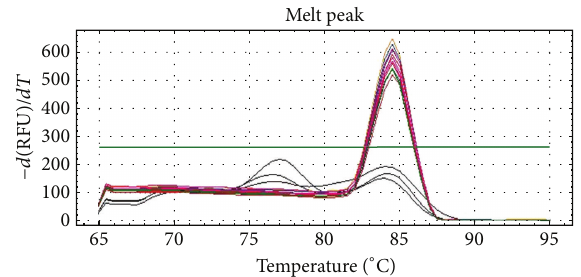
Figure 1: Melting temperature of all amplicons with serial dilution of total RNA.